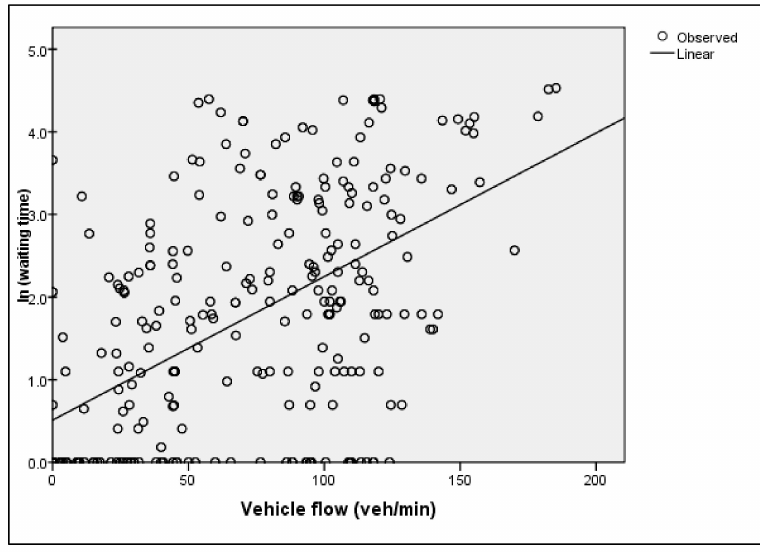
Figure A3. Linear relationship between ln(waiting time) and vehicle flow.